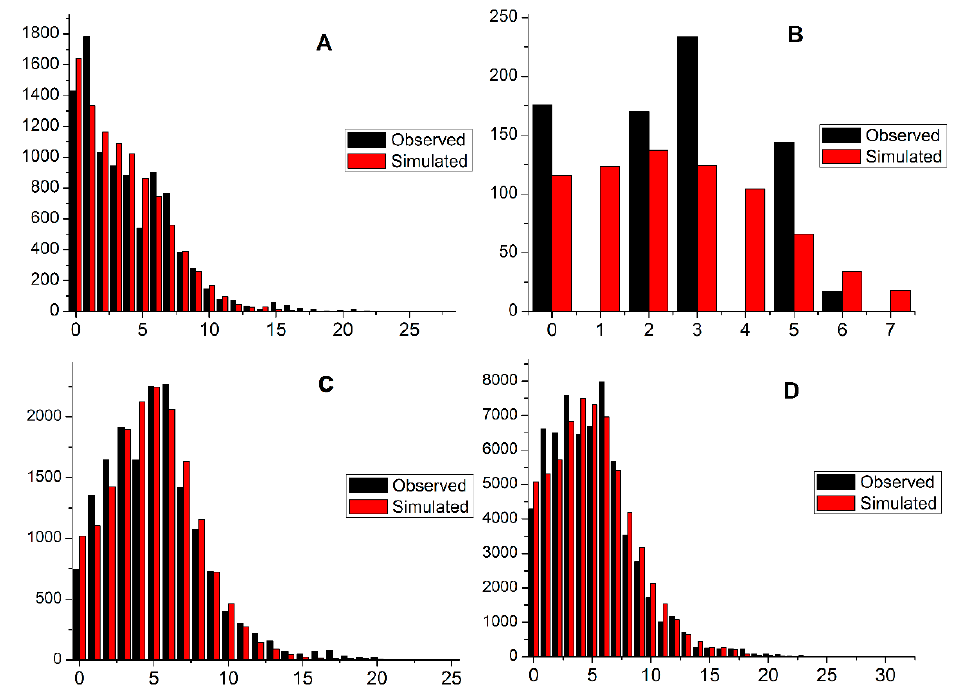
Figure 4. Observed and simulated mismatch distributions of all Bactrocera minax populations. ( A ) Central China; ( B ) Southern China; ( C ) Western China; ( D ) All populations.